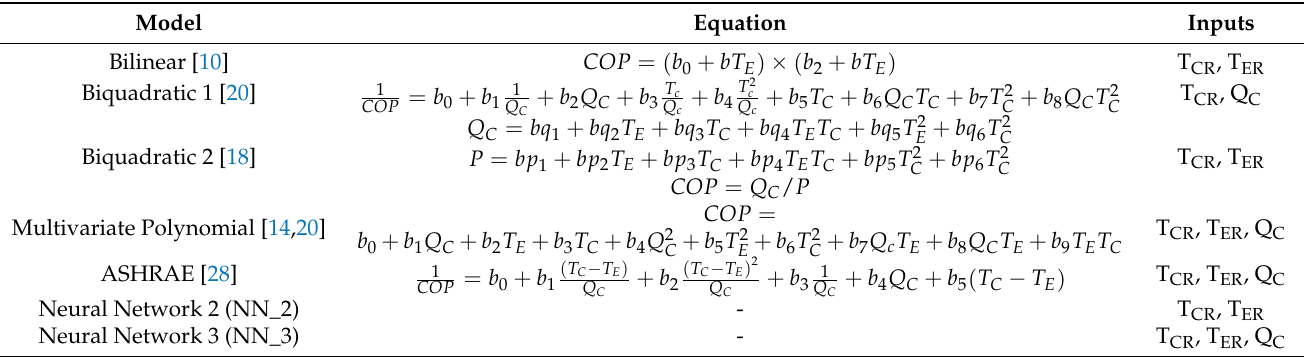
Table 2. List of